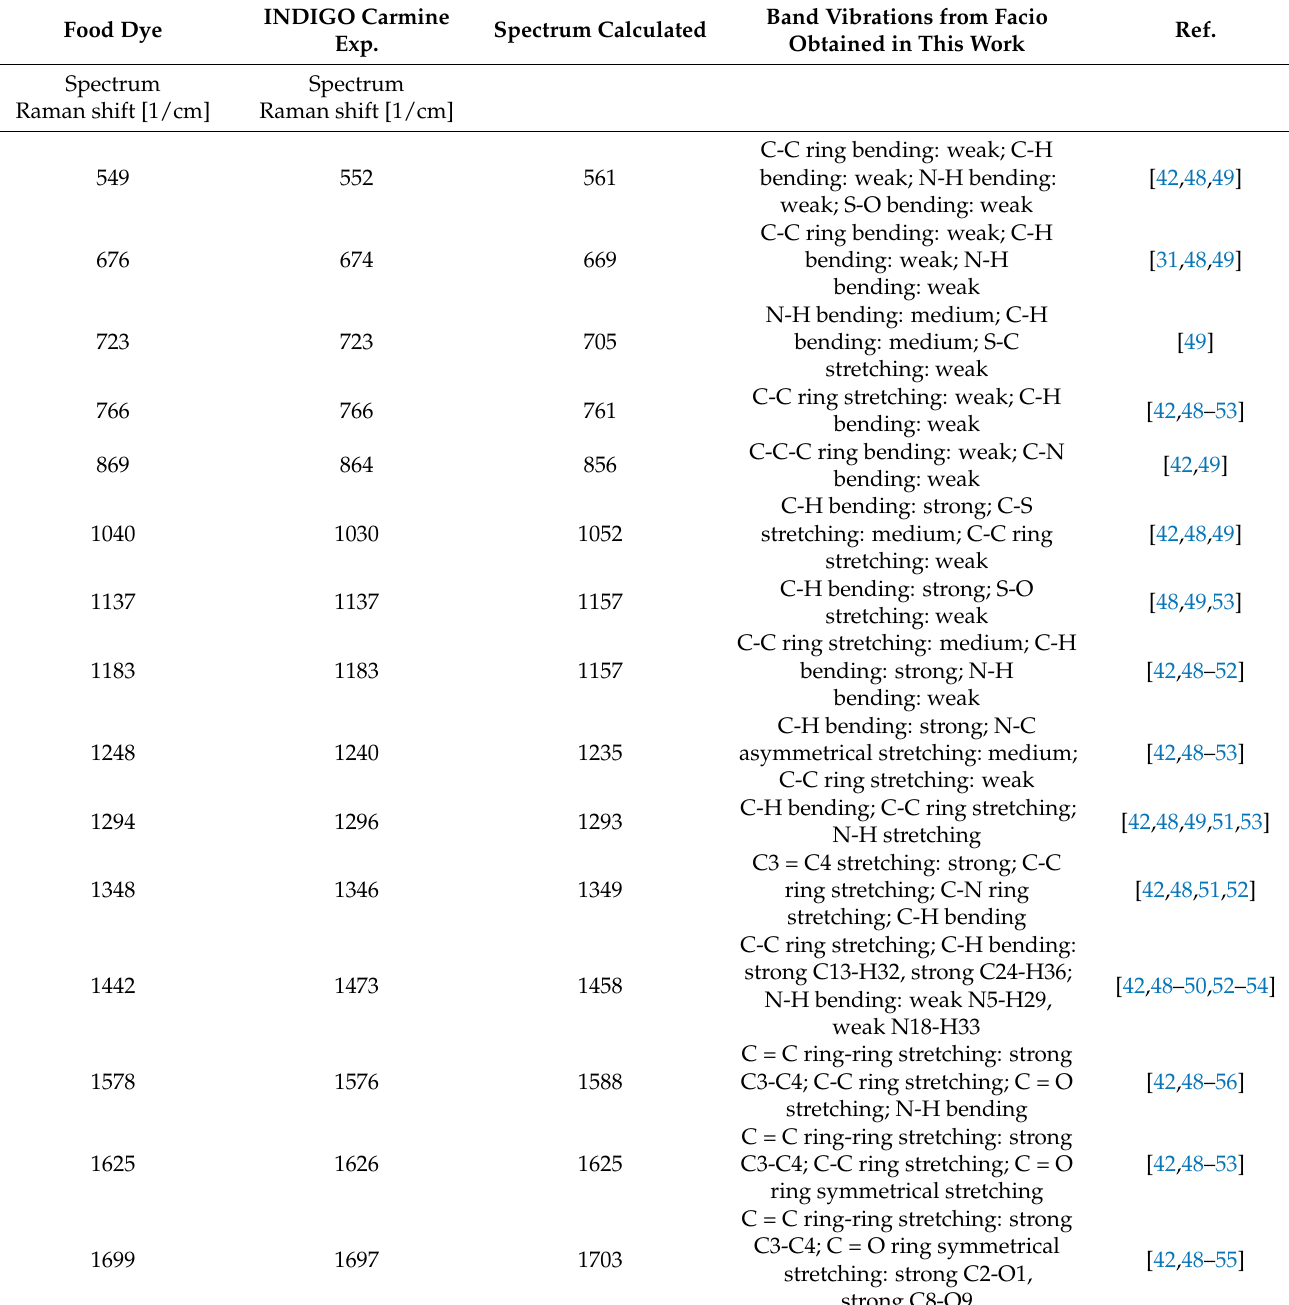
Table 1. Assignation of vibrations from the Raman spectrum of food dye indigo carmine, standard indigo carmine, and the calculated Raman spectrum for and vibrations found in Facio and comparison with literature